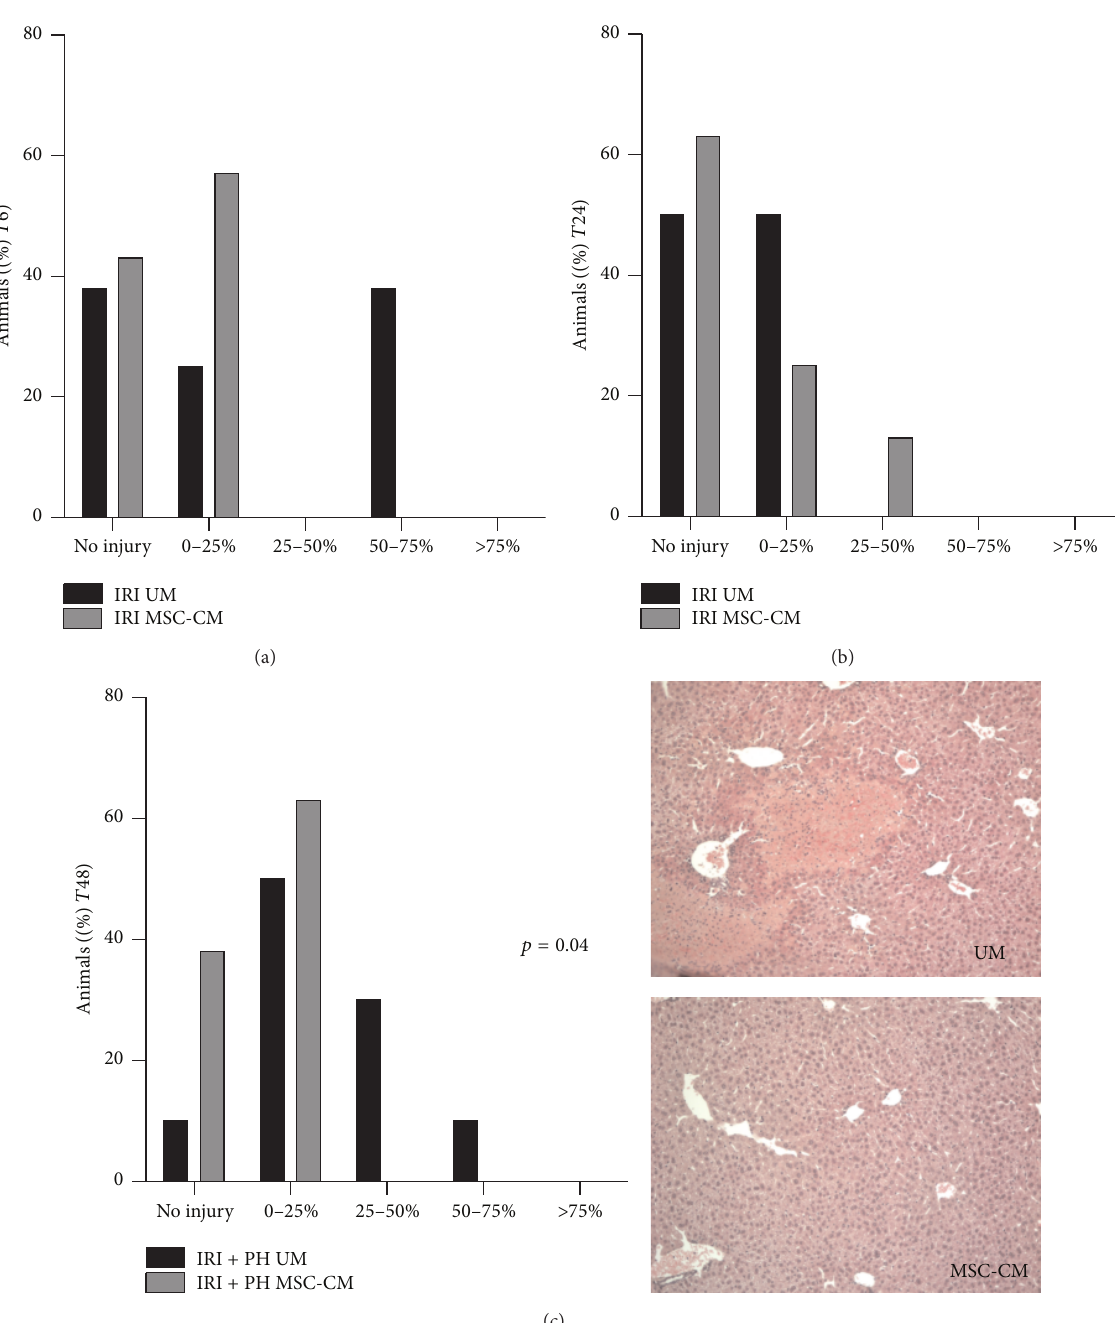
Figure 2: Effects of MSC-CM on hepatic tissue injury. H&E stained liver tissue sections were classified based on the percentage of damaged tissue: no injury, 0–25%, 25–50%, 50–75%, or > 75% of liver tissue affected. This figure shows the percentage of animals with a certain injury score (a) 6 hours after IRI, (b) 24 hours after IRI, and (c) 48 hours after IRI + PH with representative pictures showing approximately